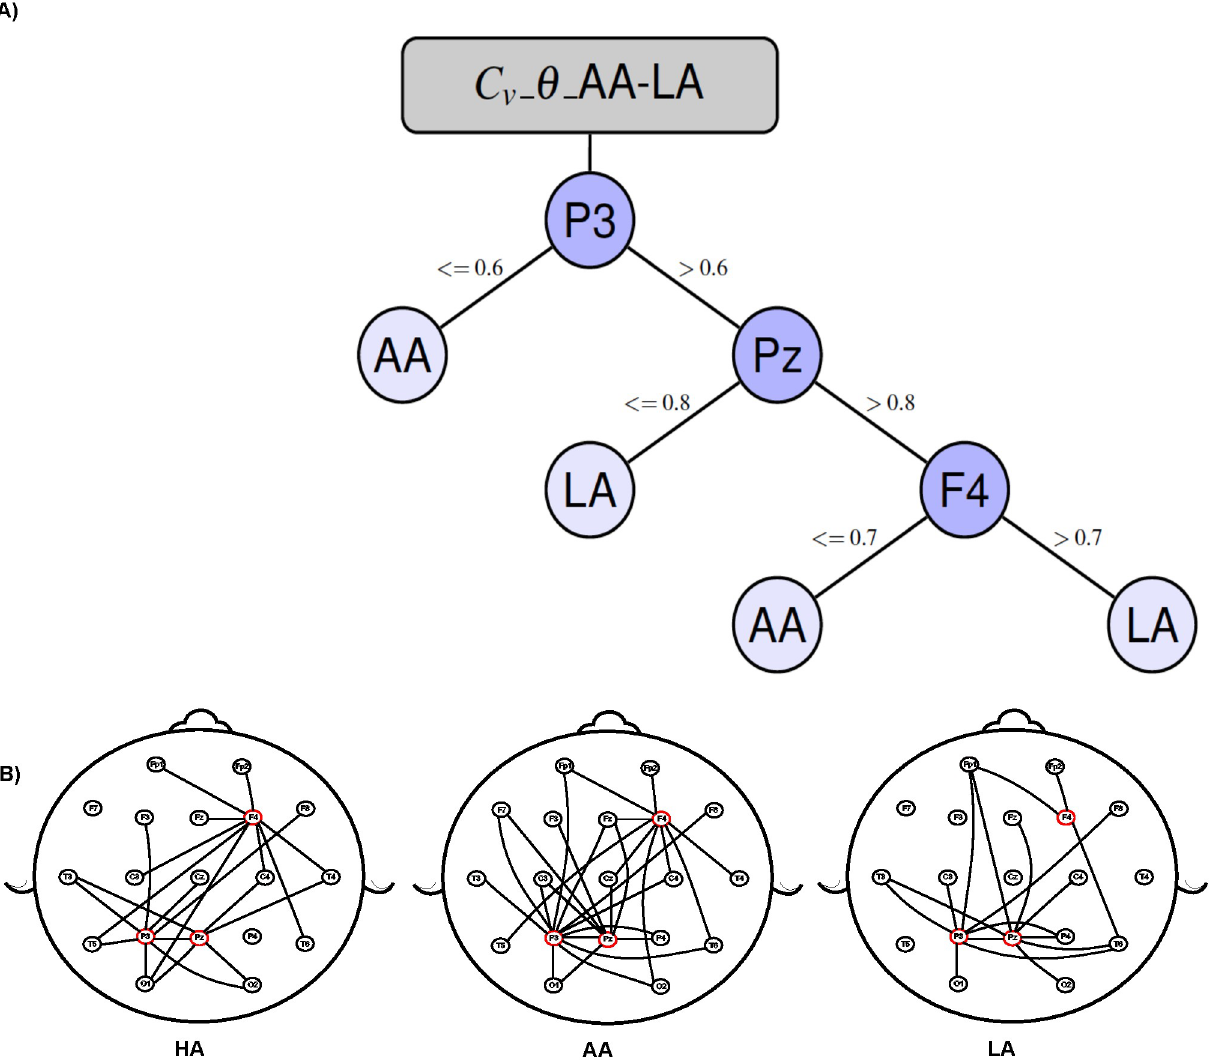
Fig 7. Decision tree model to classify average-achievement (AA) level vs. low-achievement (LA) level for the graph metric C band with a 76.77% of accuracy. Fig B depicts the average connectivity behaviour of the electrodes identified by the decision tree model for each achievement level and frequency